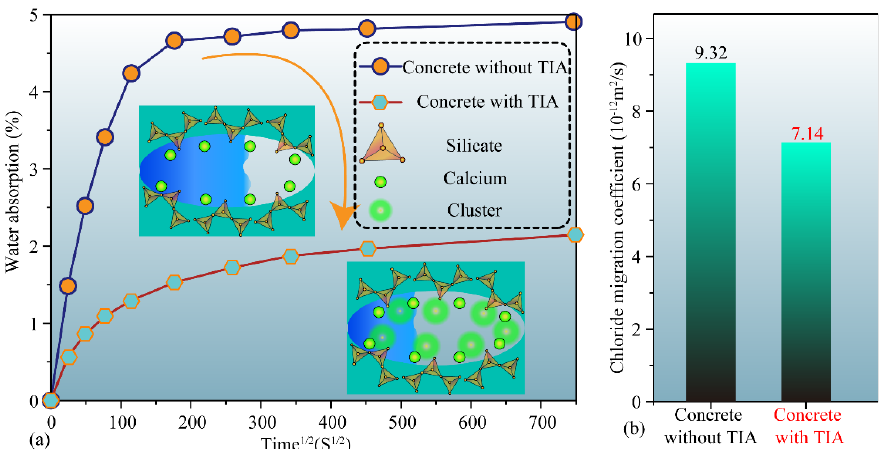
Figure 10. Water absorption and diffusion coefficients of concrete with and without TIA ( a ): the water adsorption ratio of cement pastes as a function of immersing time; ( b ) the chloride migration coeffient of concrete with and without TIA The chloride diffusion coefficient and surface chloride concentration were calculated by fitting the relevant data points into Equation (2) by means of nonlinear minimum re ‐ gression analysis. The chloride migration coefficient more directly reflects the resistance of concrete to ion erosion. Figure 10b manifests that the chloride migration rate of samples without TIA reaches 9.32 × 10 − 12 m 2 /s, while the incorporation of TIA reduces the chloride